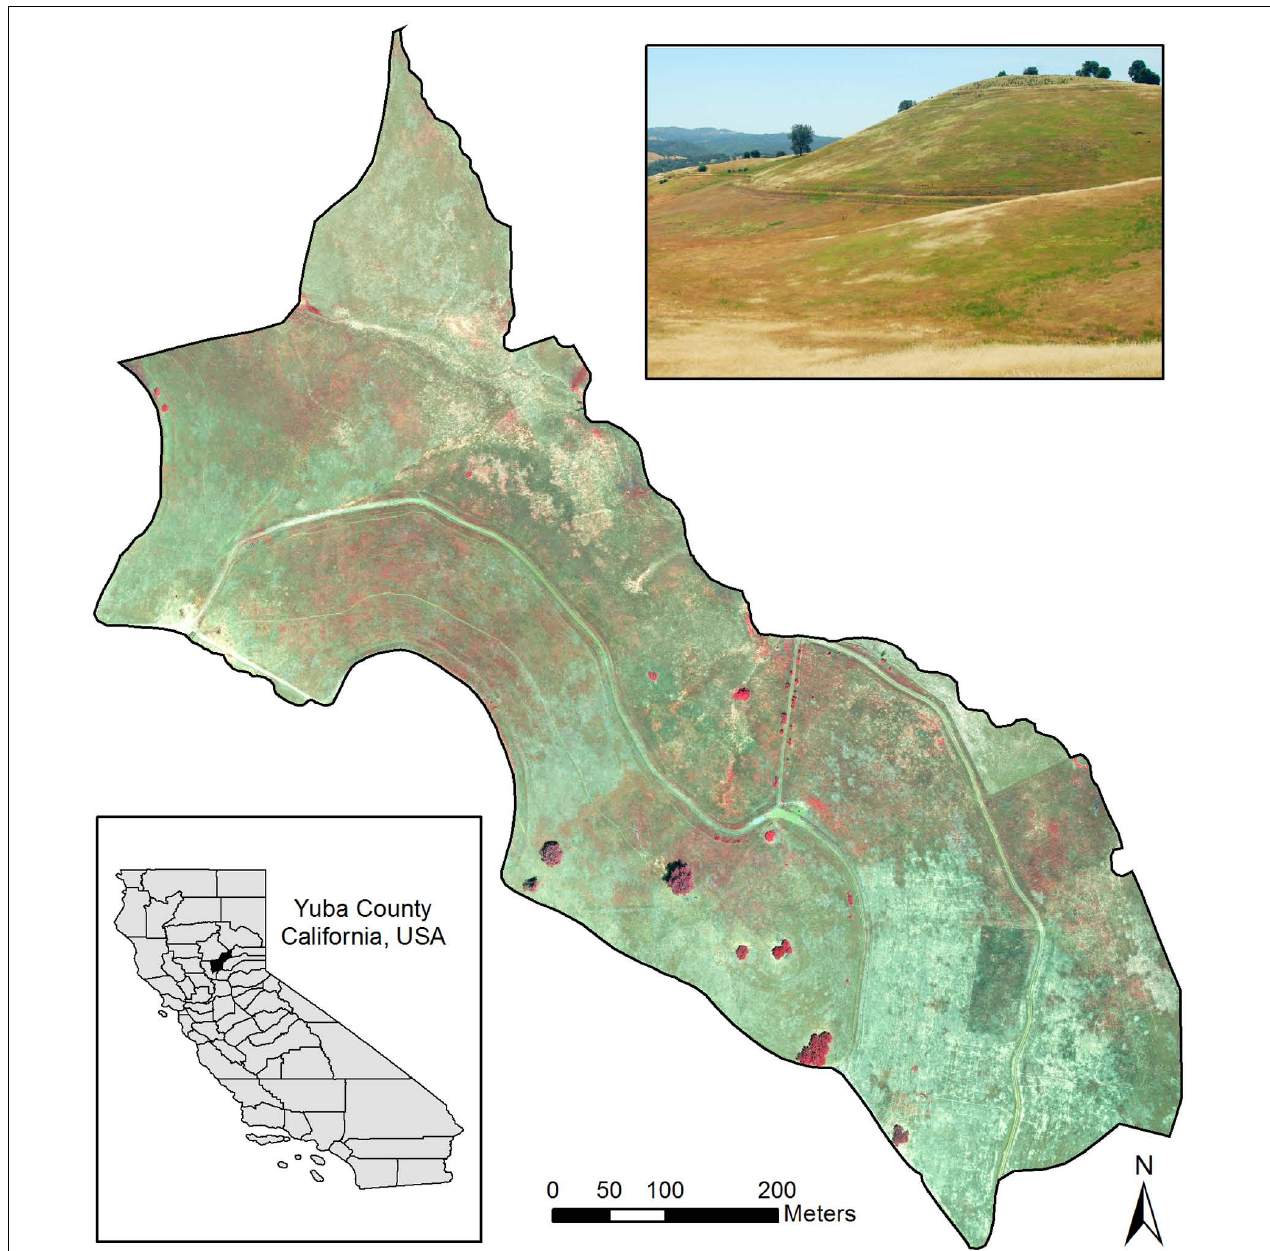
FIGURE 1 | Study area at the Sierra Foothills Research Extension Center, Browns Valley, CA, United States. The main image shows a near-infrared, red and green band composite for the classified portion of the site. The photo inset shows an example of infested areas as seen on the ground, with medusahead and other green vegetation patches amidst senescent